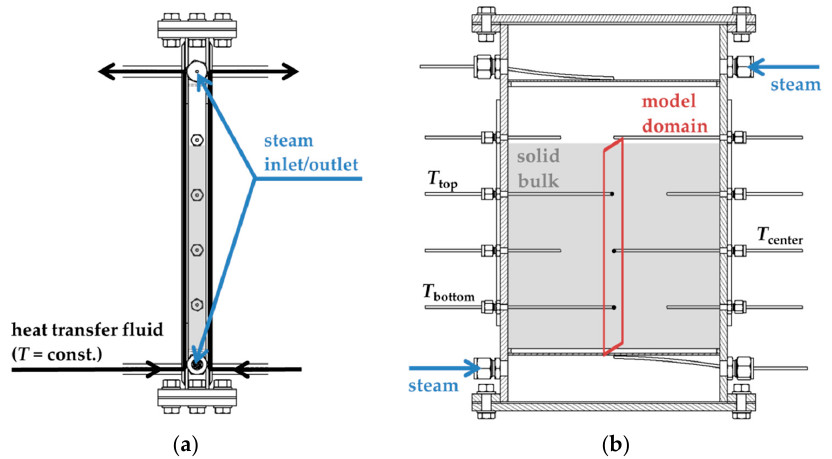
Figure 2. Schematic reactor geometry used for both modelling as well as experimental studies: ( a ) side view and ( b ) front view.